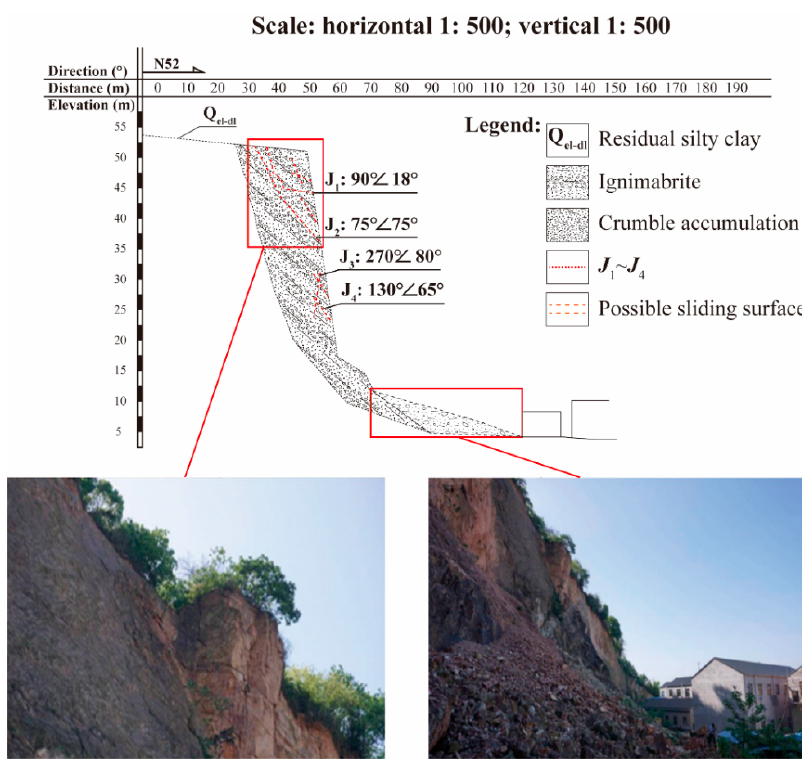
Figure 5. Cross-sectional view and the front views of the Daoxu Town quarry slope.